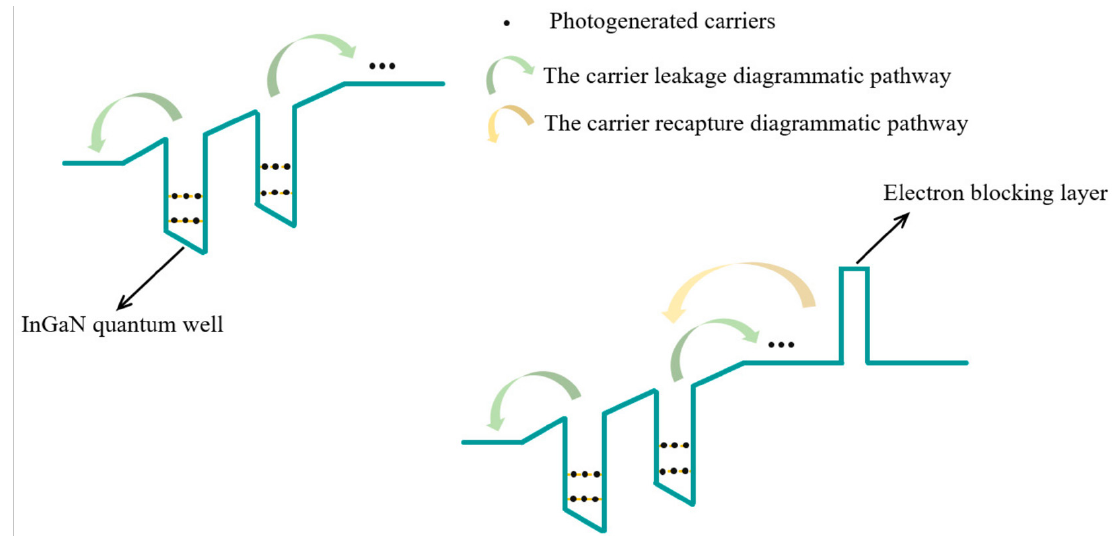
Figure 4. The schematic diagram of conduction band and carrier leakage pathway in sample 2QW and